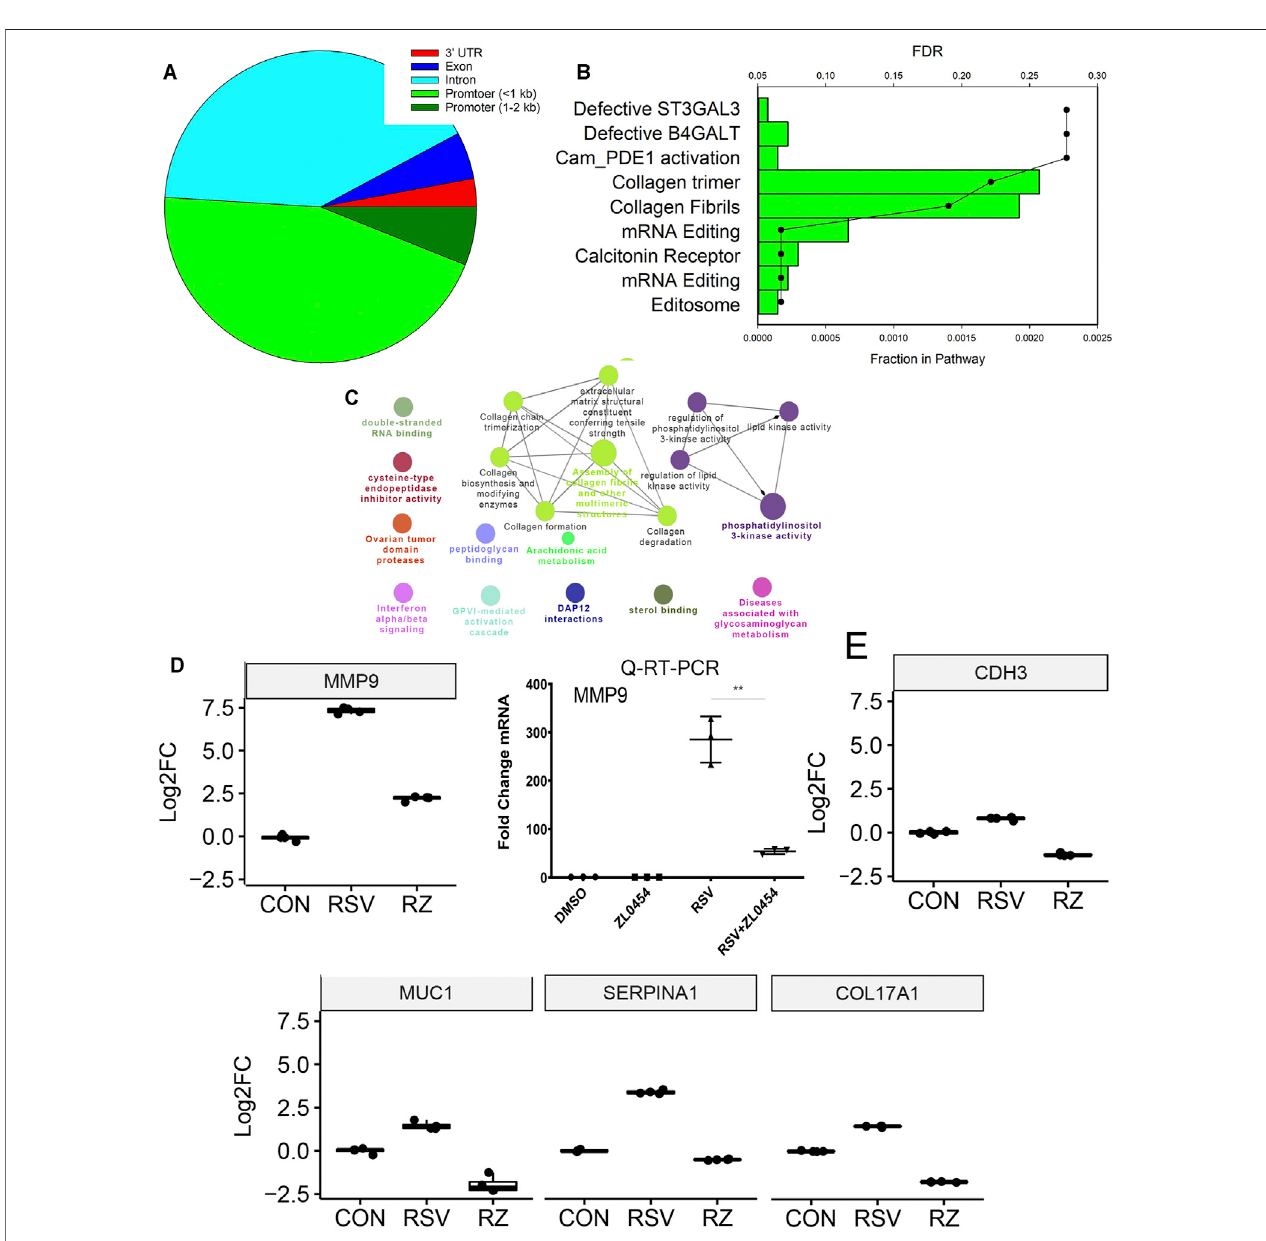
FIGURE 9 | BRD4-dependent genes with RSV-inducible chromatin. 7,845 RSV-inducible Tn5 transposase-accessible genomic cleavage sites were mapped to BRD4-dependent gene bodies. 516 peaks were mapped to BRD4-dependent genes. (A) Location ofcleavage sites on gene bodies. (B) GOenrichment analysis. Bars, fraction of pathway in datasets. Scatterplots are false discovery rate for pathway enrichment. Note the enrichment of collagen trimers and fi bril formation. (C) Integrated GO enrichment. A major network involved in ECM and collagen is indicated in green. (D) MMP9 mRNA expression in RNA-Seq is validated by qRT-PCR. Left, log2FC from RNA-Seq. Adjusted p- values is < E-100. Right, fold change mRNA by qRT-PCR. (E) mRNA expression of other ECM and structural index genes are plotted as 25 – 75% interquartile ranges. Adjusted p- values of RSV vs RSV + ZL0454 treatment are: COL17A (cid:1) E < -100; MUC1 (cid:1) 1.4E-76; SERPINA1 (cid:1) E < -100; and CDH3 (cid:1)